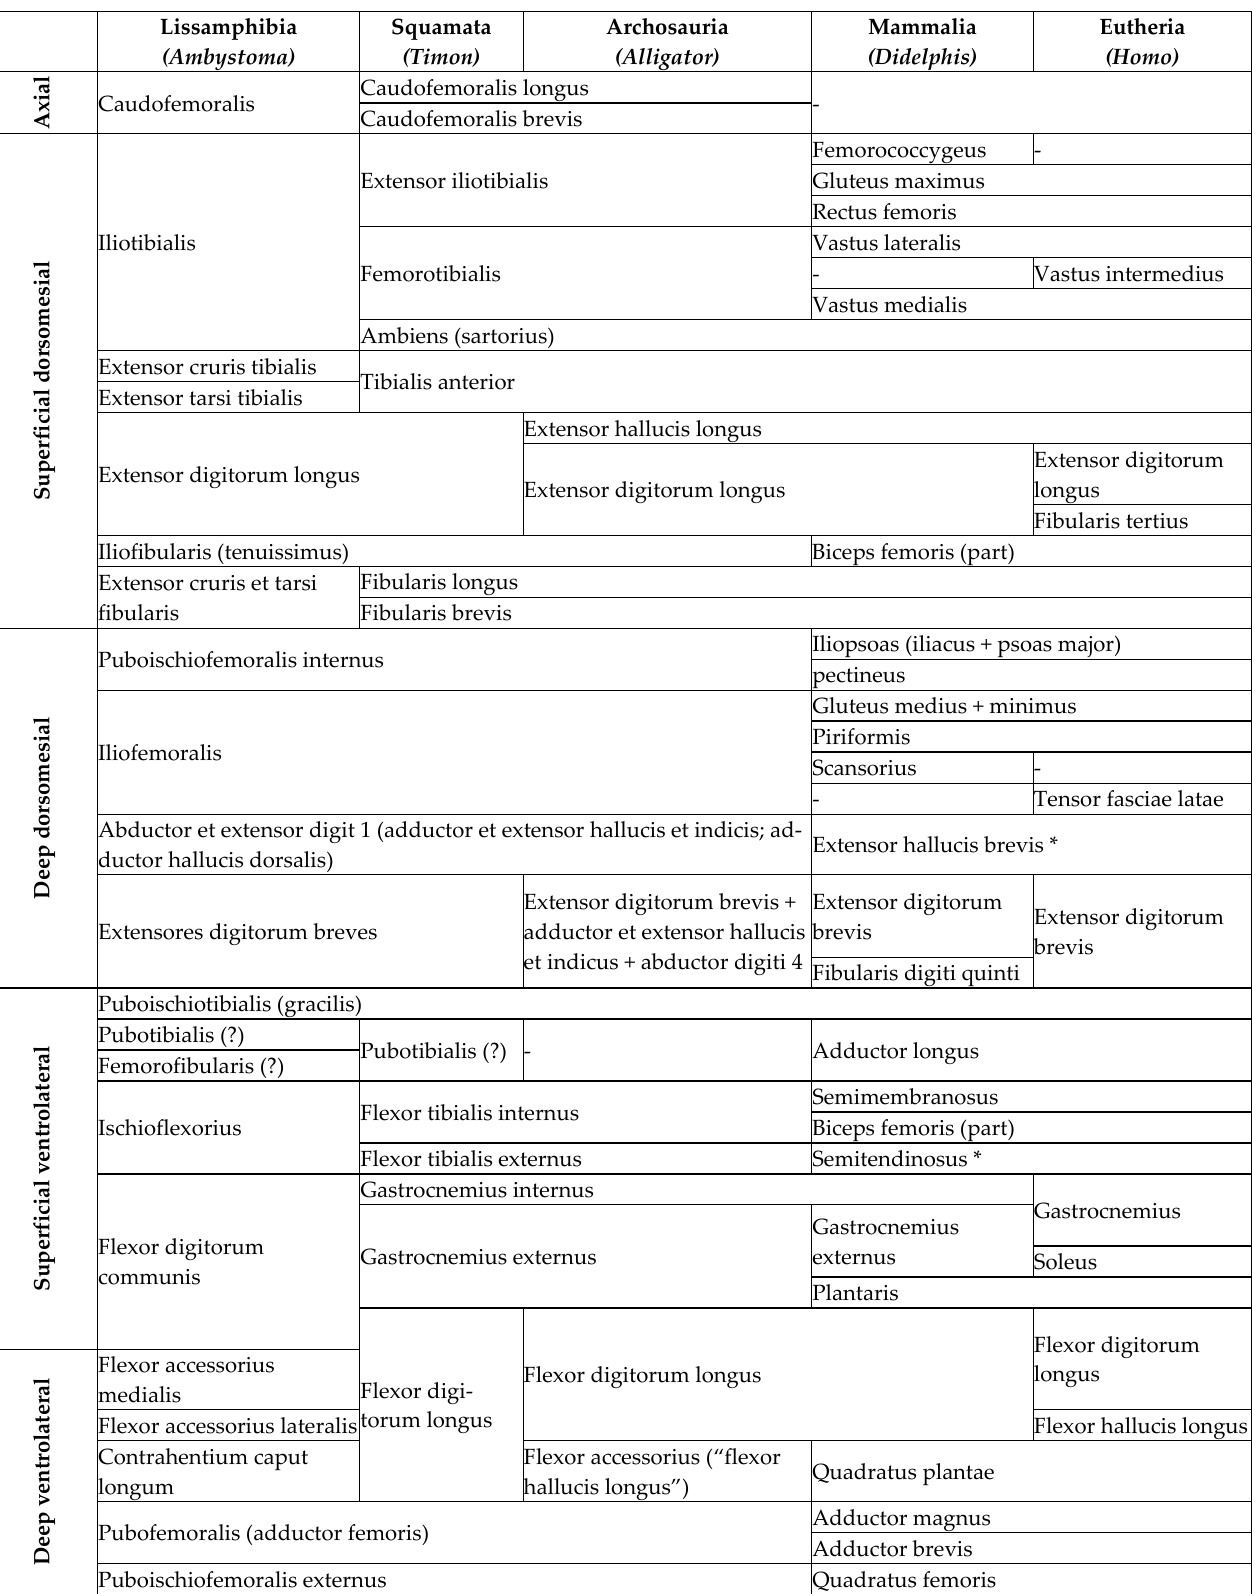
Table A2. Evolution and homologies of tetrapod hindlimb muscles. Columns as in A1. Muscles in the same row with different names indicate partial homology resulting from muscle splits or fusions. Synonyms in parentheses. * Indicates controversial or uncertain homologies. Modified from Diogo et al. [37].